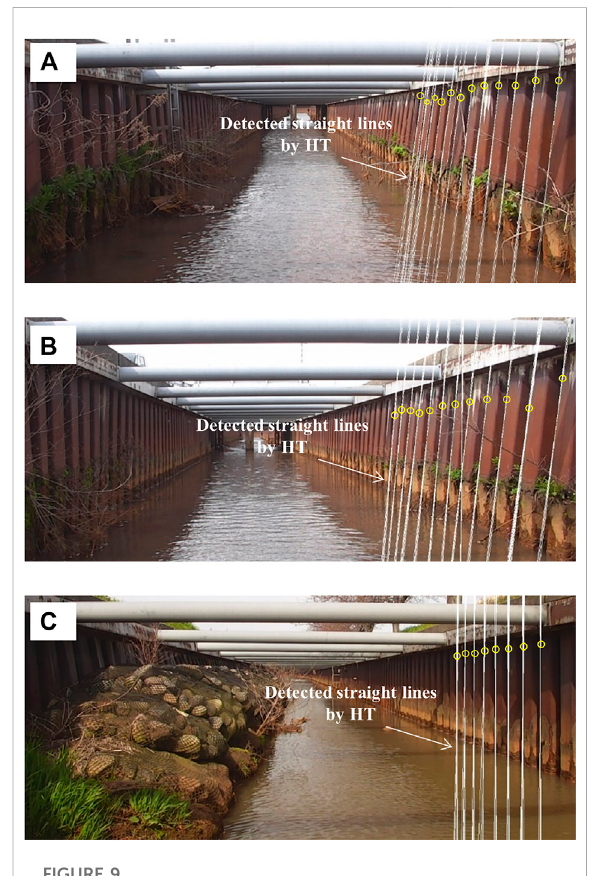
FIGURE 9 Results of line detection of steel sheet piles. White lines describe detected straight lines by Hough transform, and yellow circles describe the lines which evaluate the angle parameters. (A)